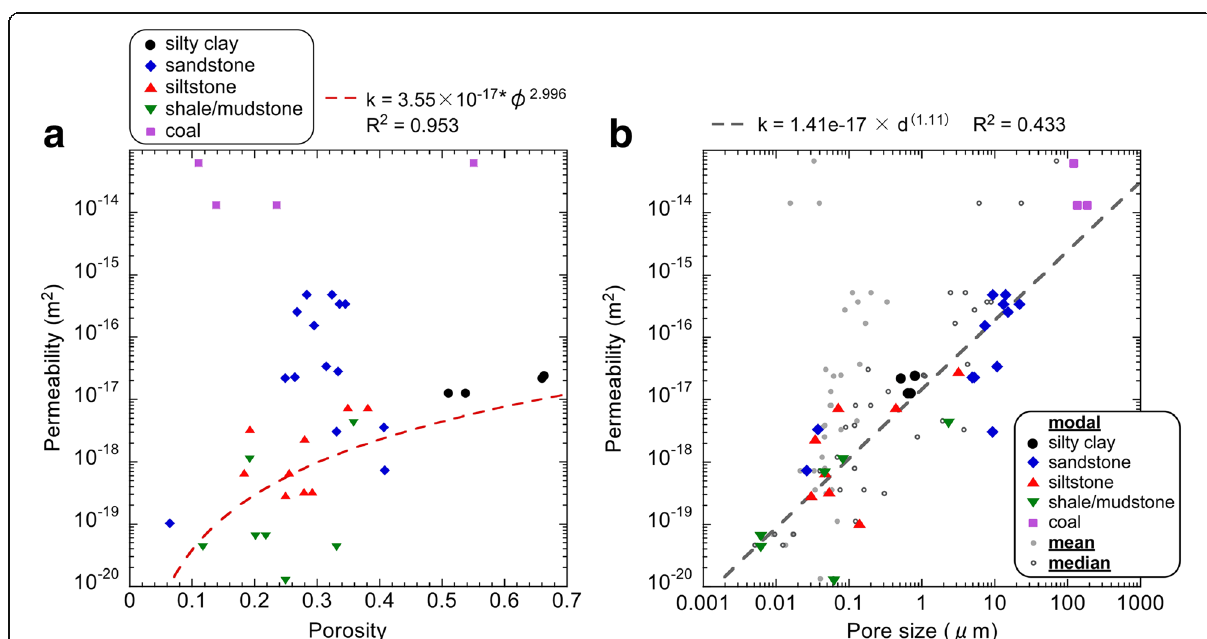
Fig. 7 a Initial porosity vs. initial permeability for the core samples used for the permeability tests. b Initial permeability plotted against the modal pore size distribution. Dashed lines show regression curves. k : permeability (m 2 ), Φ : porosity, and d : pore size ( μ